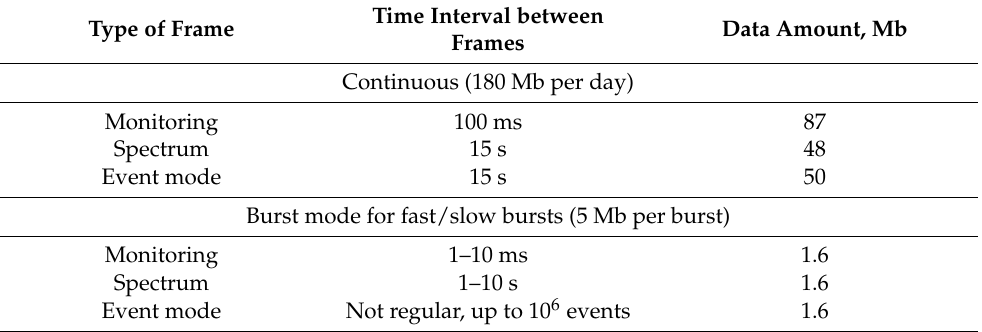
Table 2. Structure and amount of BDRG output data. Type of Frame